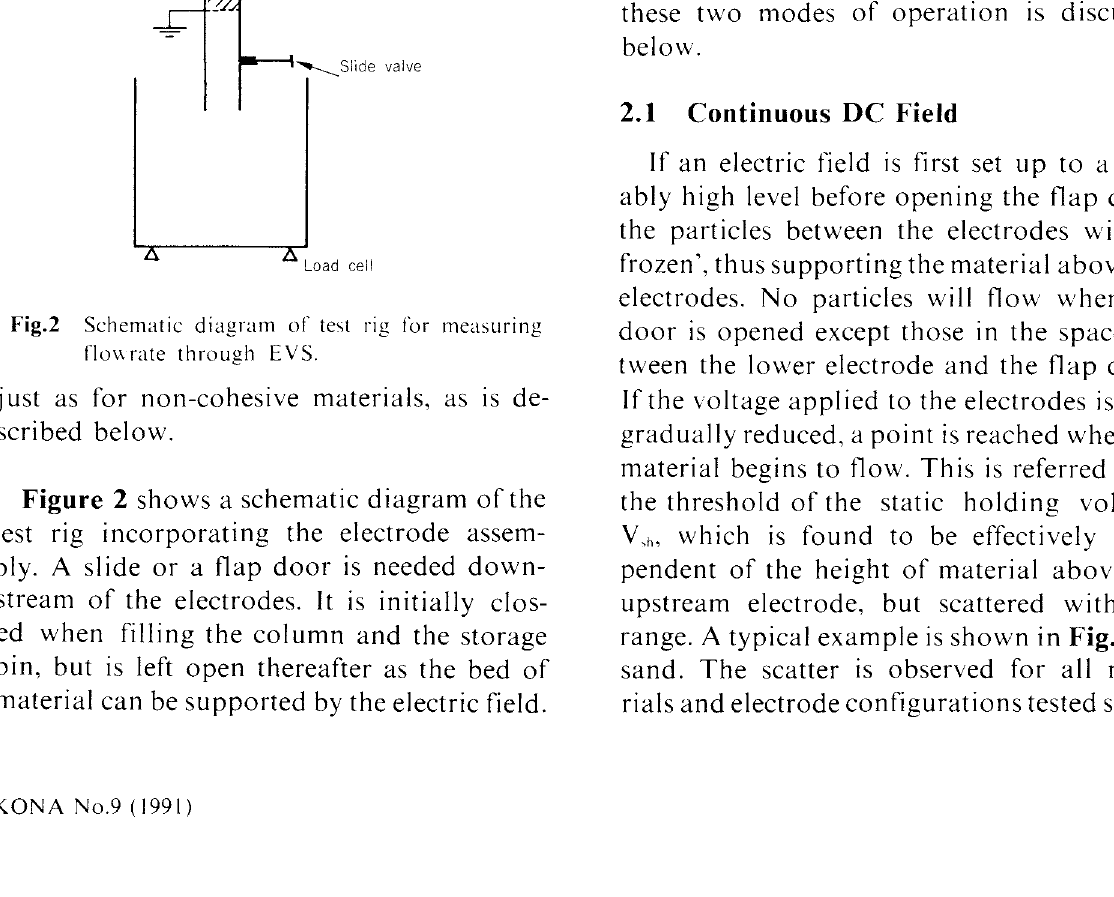
Effect of height of material on static holding voltage for 600-1200 ,urn sand in I 15 mm column. Upper electrode: cross-wire: lower electrode mesh opening: I 0 mm: inter-electrode gap (I EG ): 36